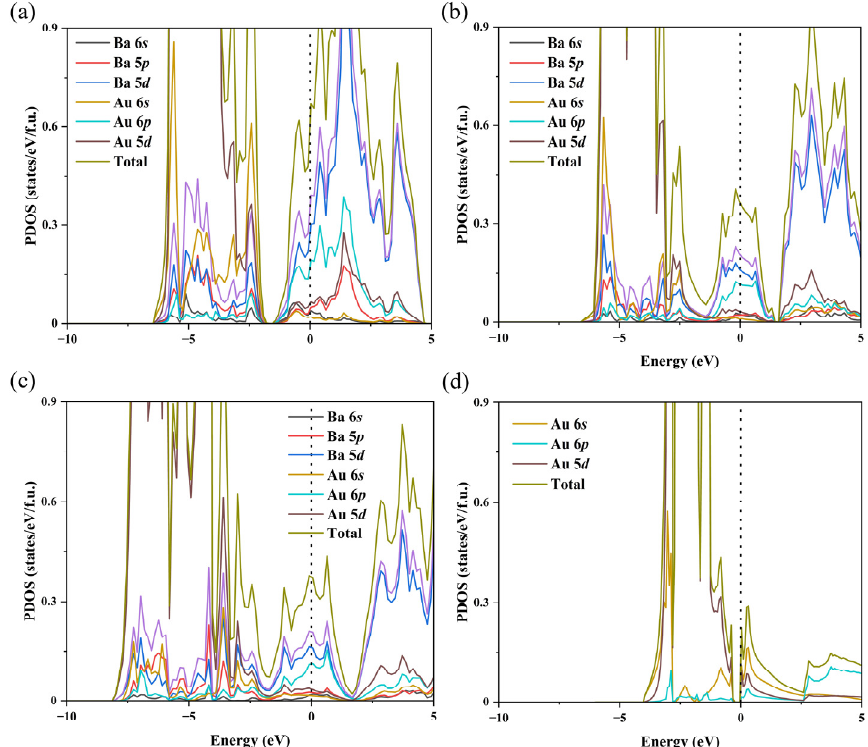
Figure 3. ( a ) PDOS calculated using the Perdew–Burke–Ernzerhof functional for BaAu in the Pnma structure at 10 GPa. PDOS calculated for BaAu in the Fd -3 m structure at ( b ) 25 GPa, ( c ) 100 GPa, and ( d ) hypothetical Ba 0 Au at 25 GPa. The dashed line at zero indicates the Fermi energy.